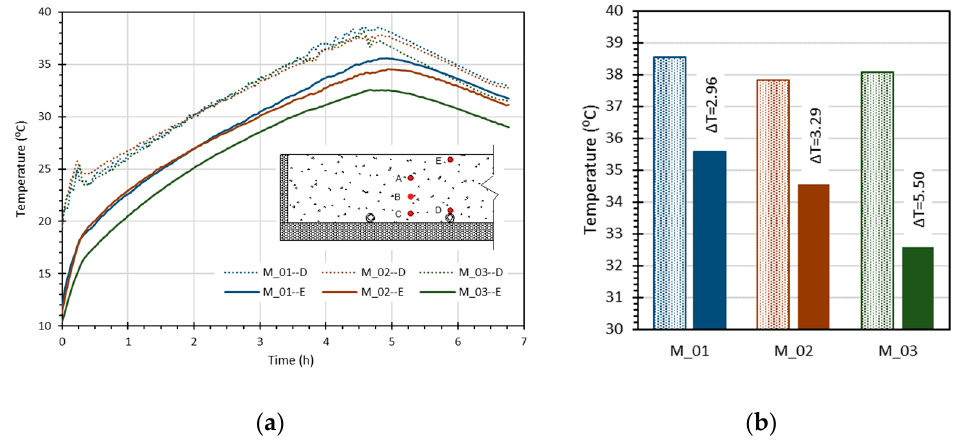
Figure 4. Test results: ( a ) temperature variation and ( b ) maximum temperature reached in the mor- tars.